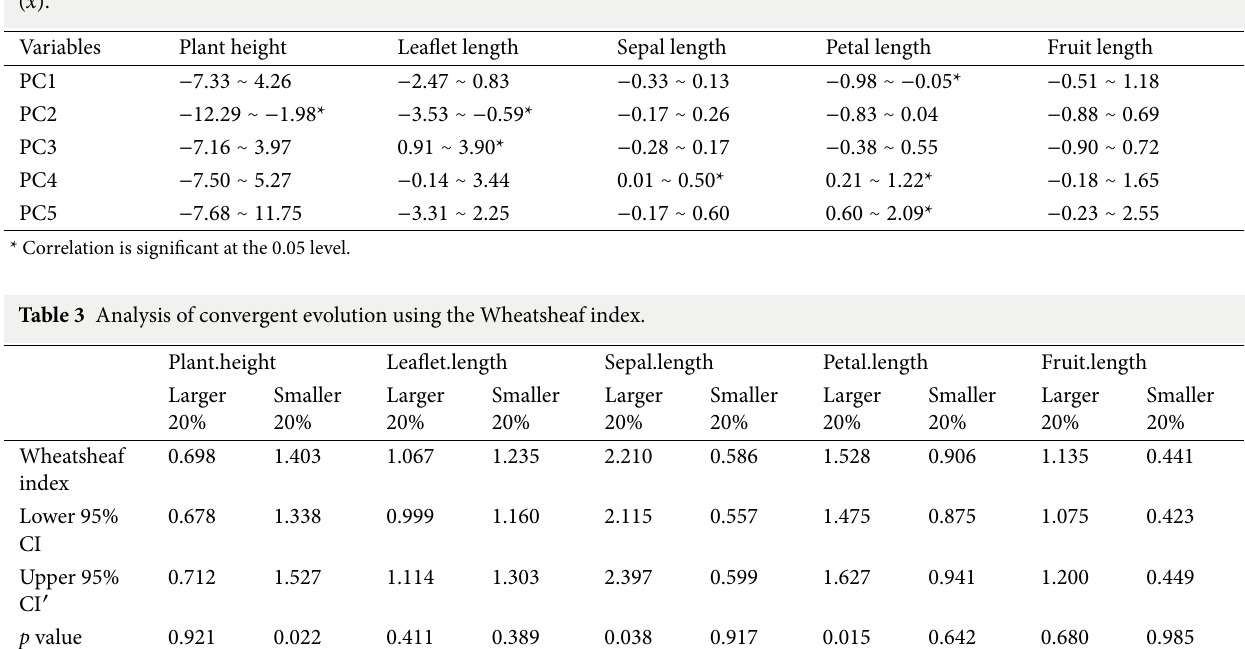
Table 2 The 95% confidence intervals for slope parameters of fitted regression lines between plant traits ( y ) and environmental factors ( x ).